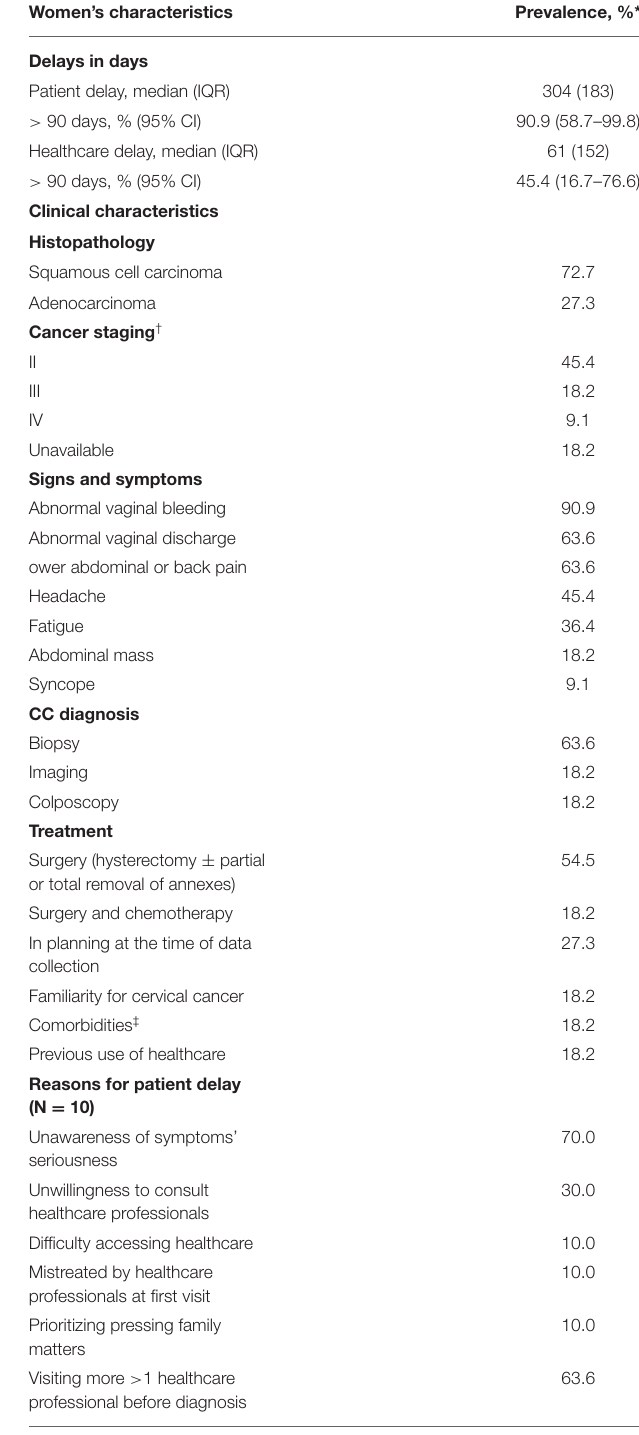
* Percentages unless otherwise specified. † FIGO (International Federation of Gynecologists and Obstetrics) 2018 staging classification (19). ‡ Comorbidities included self-reported major cardiovascular, respiratory, and kidney diseases, and cancer: in the present sample only two women reported having hypertension. IQR, inter-quartile range. CI, confidence